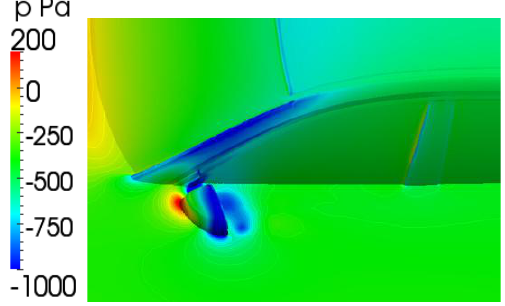
Figure 14. Pressure contour obtained using the SLM method at t = 0.765 s. Figure 15. Pressure contour obtained using the DSLM method at t = 0.765 s.